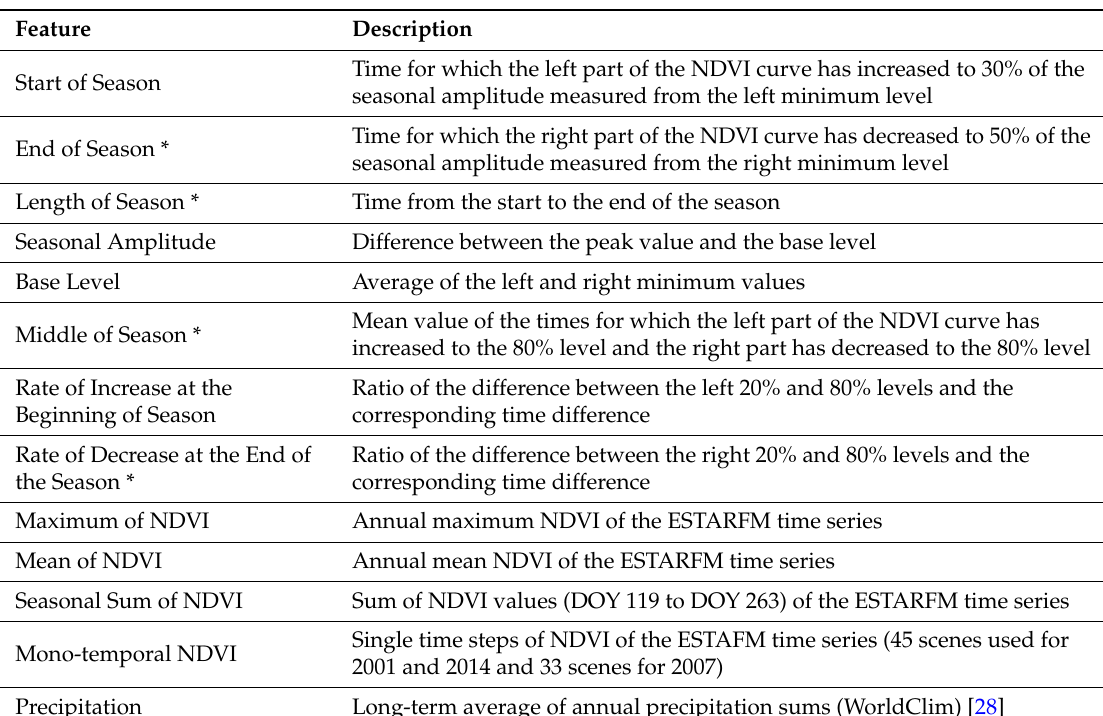
Table 2. Features used for the classification. The top eight features were generated with TIMESAT [40]. Features marked with an * could not be generated from the Landsat data available for